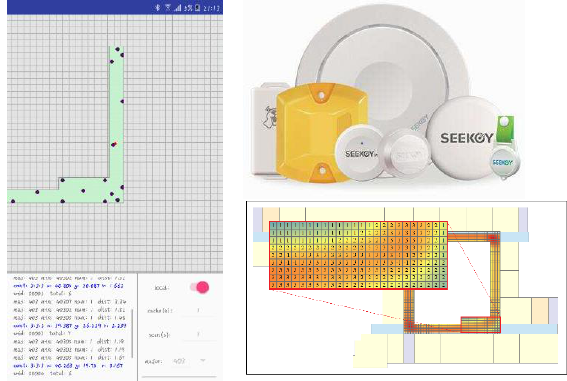
Figure 11. Experimental environment in this paper